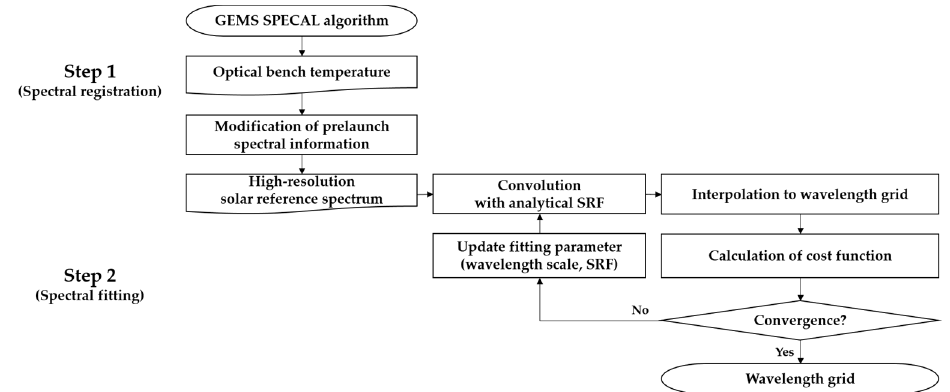
Figure 1. Flow chart of Geostationary Environment Monitoring Spectrometer (GEMS) spectral calibration algorithm (SPECAL). In-flight SPECAL for GEMS consists of two processes. The first step is wavelength assignment based on the gradient of the optical bench temperature. Initial wavelengths measured during the prelaunch laboratory test are modified by considering the actual optical bench temperature during the on-orbit measurement. In the second step, calibration is performed by fitting using Fraunhofer lines in the solar spectrum. The fitting parameters such as wavelength scale and spectral response function (SRF) are updated at each iteration step until the cost function between reference spectrum and observed solar GEMS satisfies the criteria.